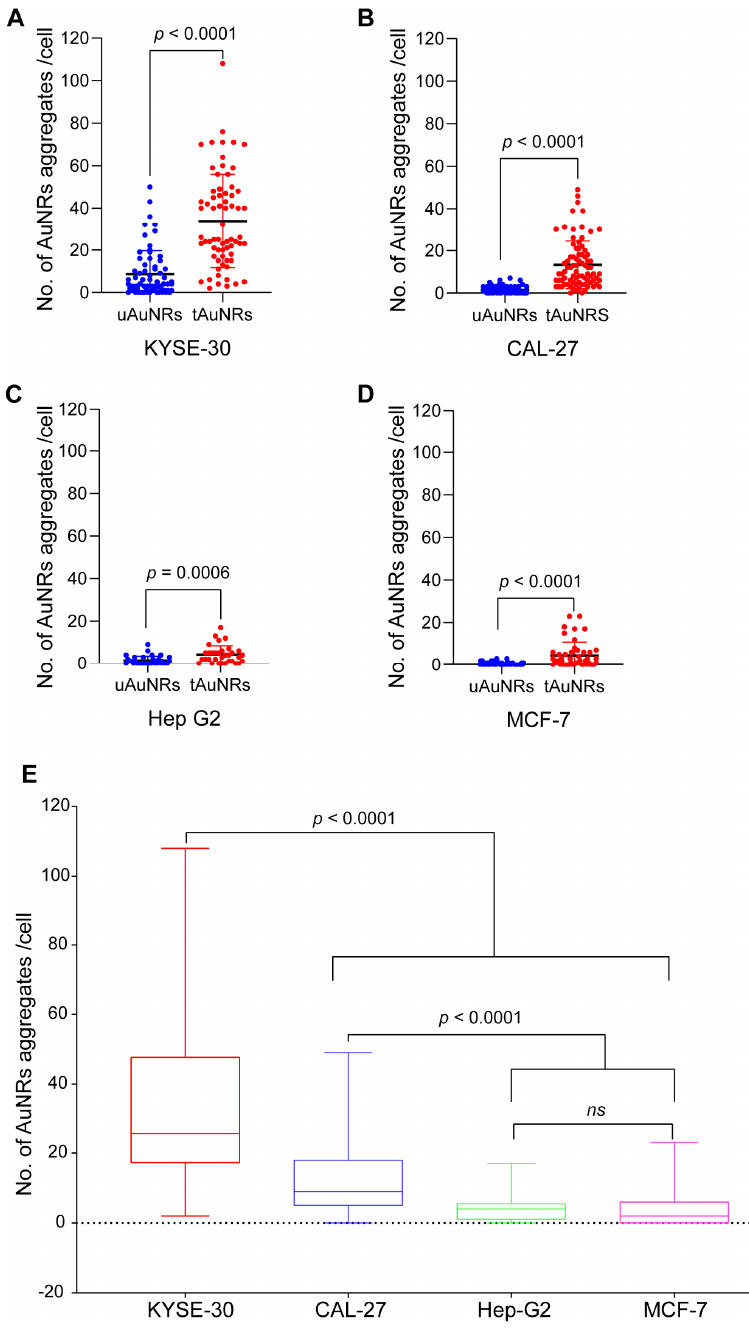
Figure 5. Targeting increased the number of AuNRs in cancer cells. ( A–D ) Dot plots show a qualitative quantification of AuNRs aggregates with a strong optical scatter from aggregates imaged and counted per cell. Mann–Whitney test showed that there was a significantly higher number of AuNRs aggregates counted in tAuNRs than in uAuNRs in: ( A ) KYSE-30 ( p < 0.0001); ( B ) CAL-27 ( p < 0.0001); ( C ) Hep G2 ( p = 0.0006) and ( D ) MCF-7 ( p < 0.0001). ( E ) Comparison of the number of tAuNRs aggregates per cell showed a significantly increased number of tAuNRs aggregates in EGFR- positive compared with EGFR-negative cancer cell lines. The total number ( n = 459) of cells counted were: KYSE-30, 68 for each tAuNR and uAuNR; CAL-27, 68 for uAuNR and 83 for tAuNR; Hep G2, 33 for each uAuNR and tAuNR; MCF-7, 59 for uAuNR and 47 for tAuNR. Box plot shows median and range with their statistical significance where ns indicates ‘not significant’ statistical